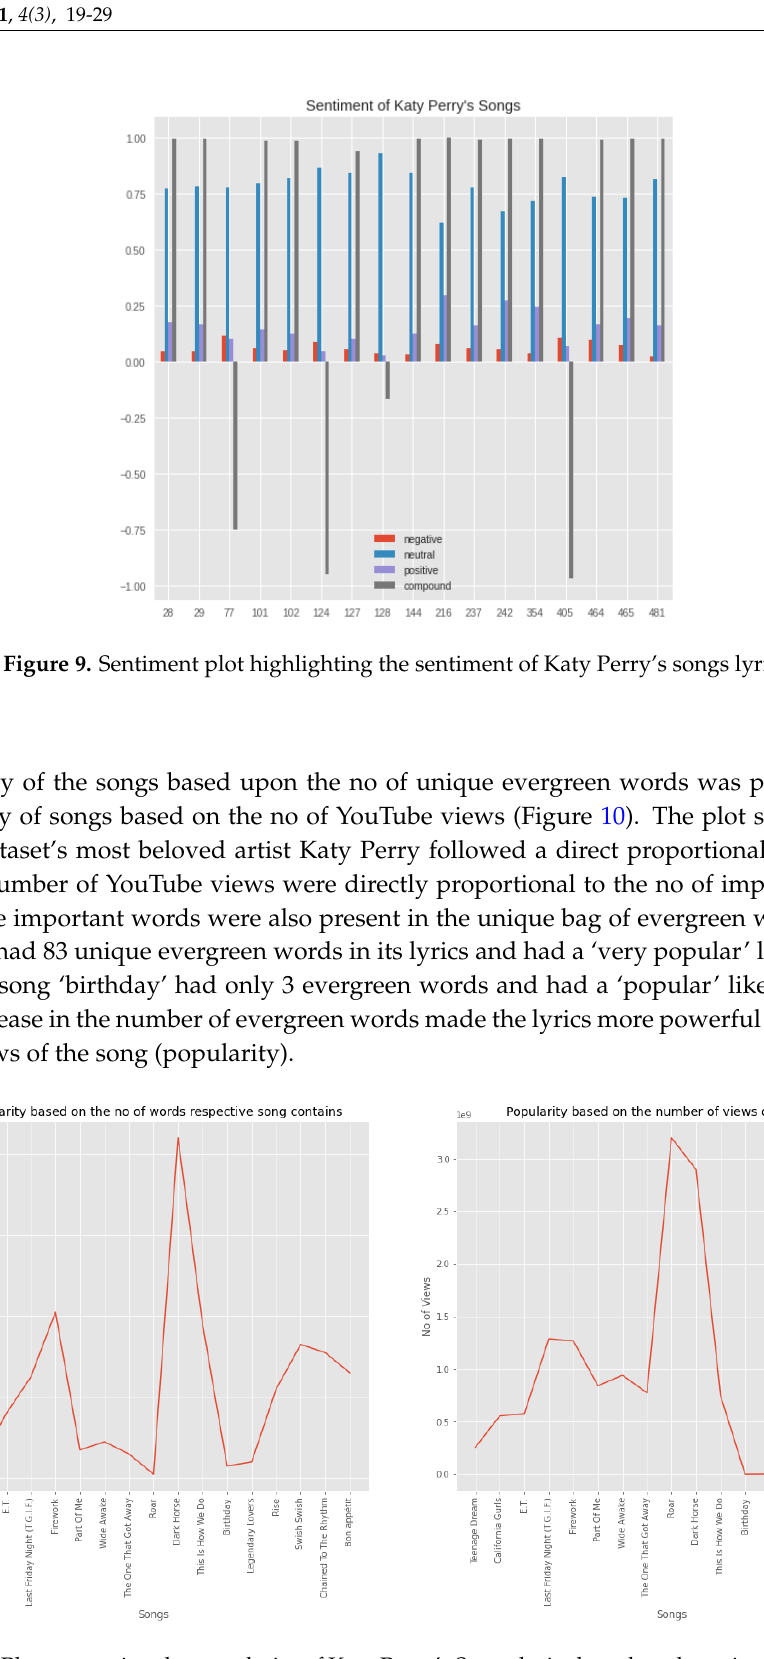
Figure 10. Line Plot comparing the popularity of Katy Perry’s Songs lyrics based on the unique evergreen